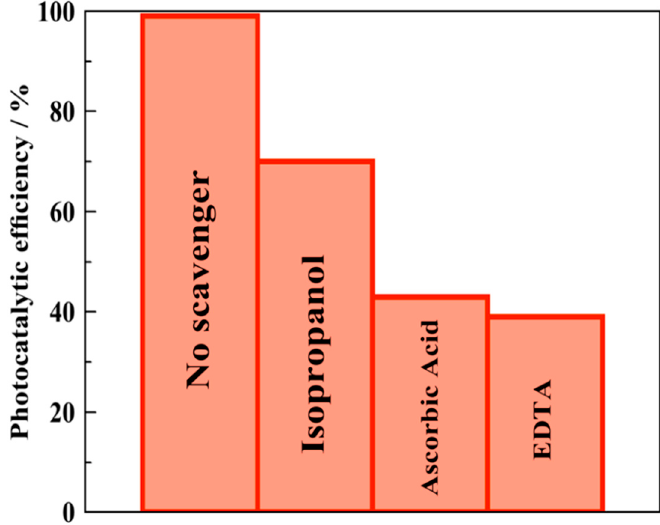
Figure 10. The effect of the scavengers on MB degradation.